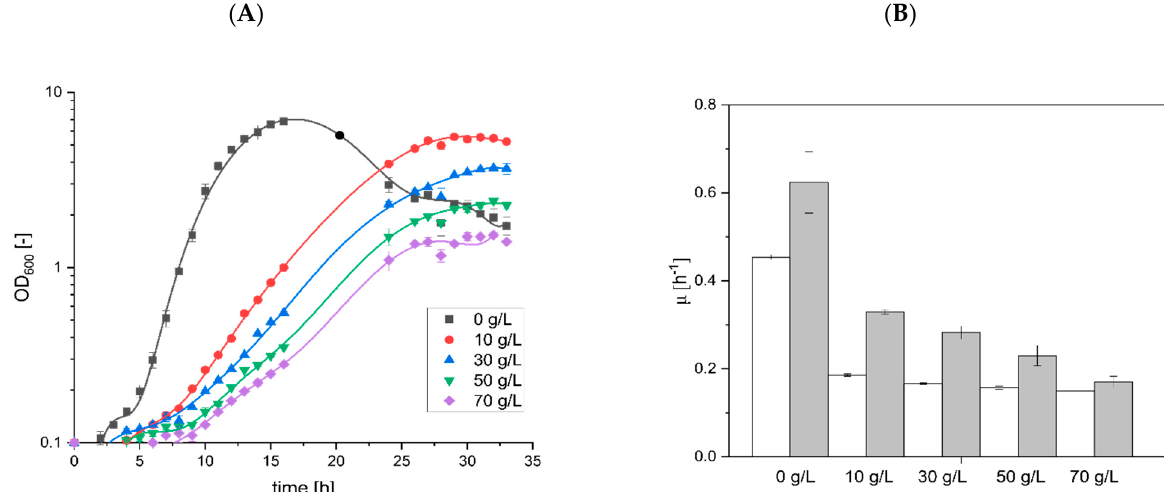
Figure 3. Effect of surfactin on B. subtilis during cultivation in defined mineral salt medium. ( A ) The B. subtilis KM0 strain was cultivated in mineral salt medium containing 8 g/L glucose. In addition, different surfactin concentrations of 0 (black squares), 10 (red dots), 30 (blue triangles), 50 (green inverted triangles) and 70 g/L (violet diamonds) were added to the cultivation medium. Cell growth was monitored hourly. A polynomial curve fit of the order of 9 was integrated using the Origin graphing tool. ( B ) The effect of the surfactin present during cultivation was determined using the overall growth rates calculated for the exponential growth phase (white bars) and the maximum specific growth rates during the cultivation process (grey bars). All cultivations were performed in biological